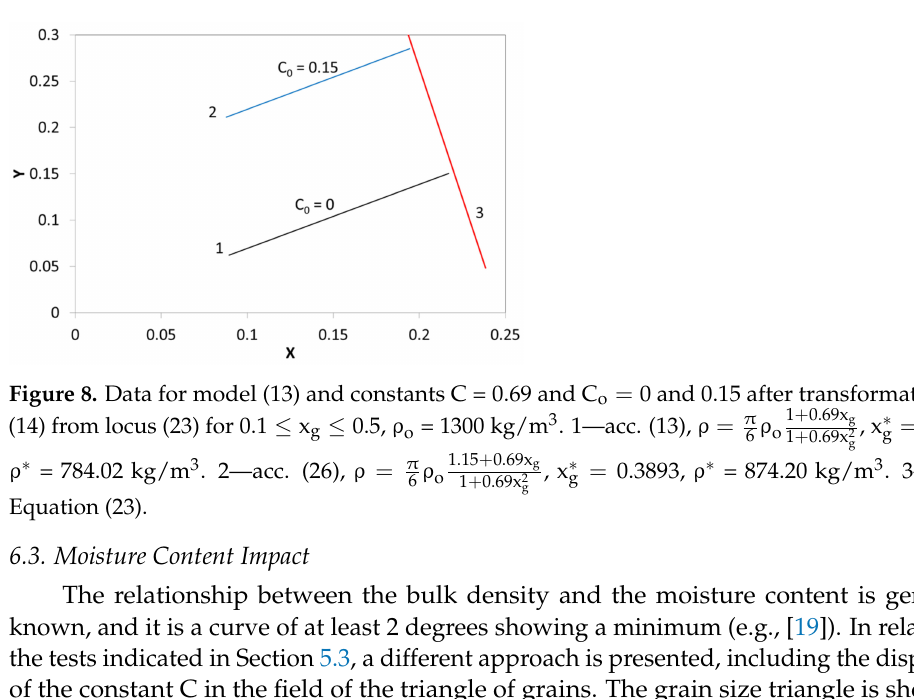
1.15 + 0.69x g ρ , x ∗ g = 0.3893, ρ ∗ = 874.20 kg/m 3 . 3—locus o 6 1 + 0.69x 2 g